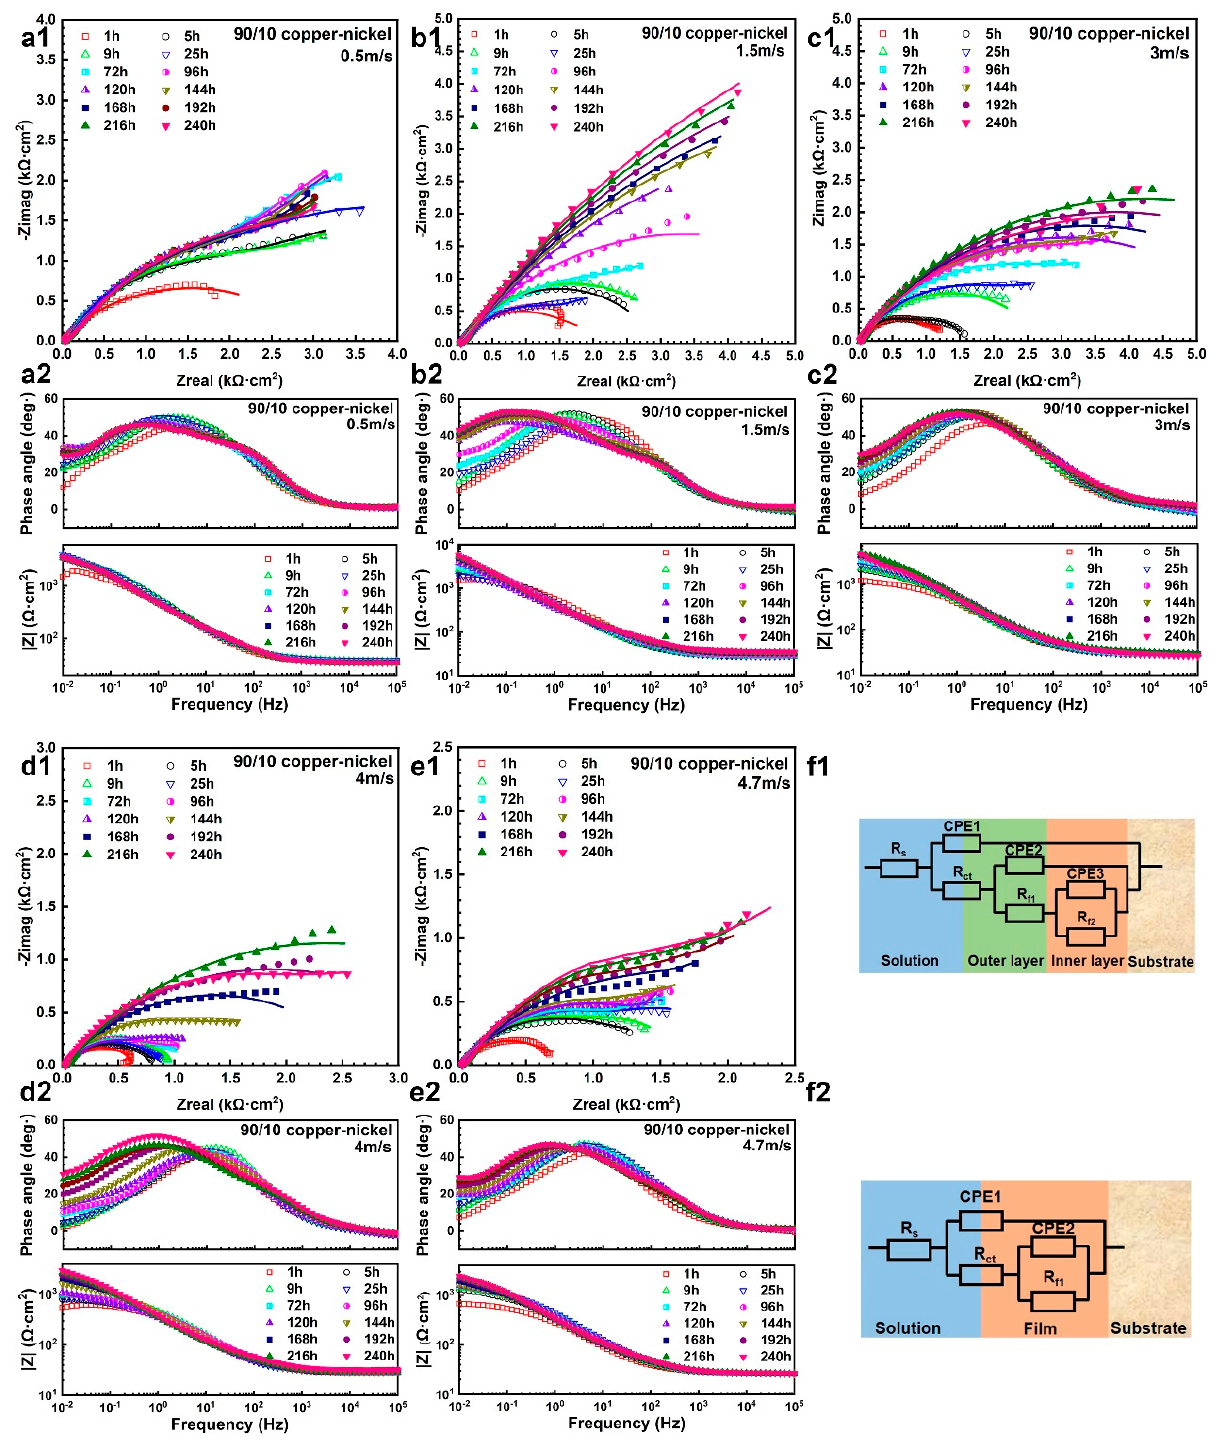
Figure 2. Nyquist plots and Bode plots of the 90/10 samples monitored during the 10-day erosion– corrosion tests at flow velocities of 0.5 m/s ( a1 , a2 ), 1.5 m/s ( b1 , b2 ), 3 m/s ( c1 , c2 ), 4 m/s ( d1 , d2 ), and 4.7 m/s ( e1 , e2 ); the equivalent circuits used for EIS fitting tested at lower flow velocities of 0.5 m/s and 1.5 m/s ( f1 ) and at higher flow velocities of 3 m/s, 4 m/s, and 4.7 m/s ( f2 ).